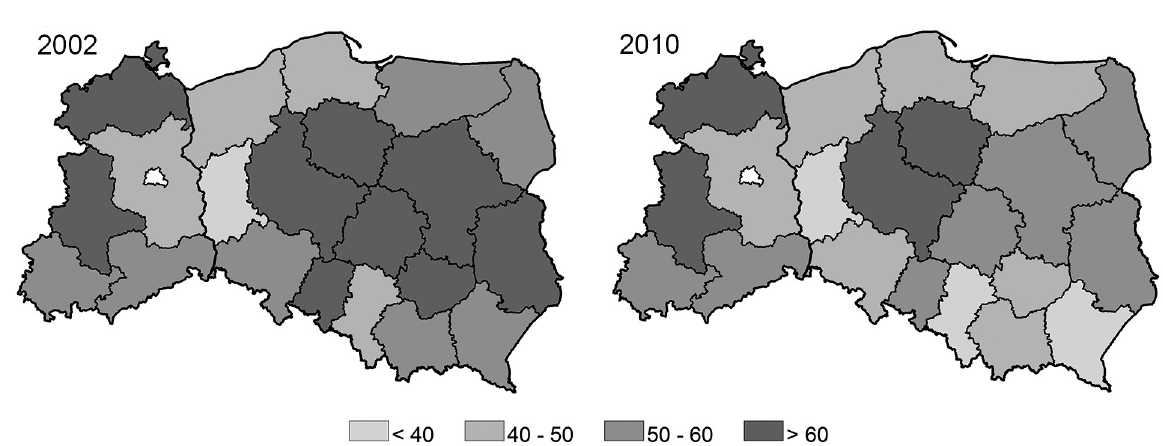
Fig. 1. Share of farmland in voivodeships in Poland and Länder in East Germany in 2002 and 2010 (%) Source: authors’ own calculation based on German 2011 data and Polish 2002 and 2010 Agricultural Censuses